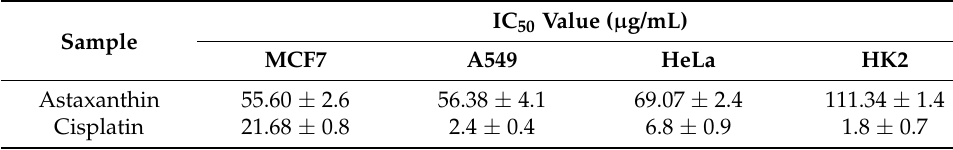
Table 6. IC 50 values of anticancer activity of